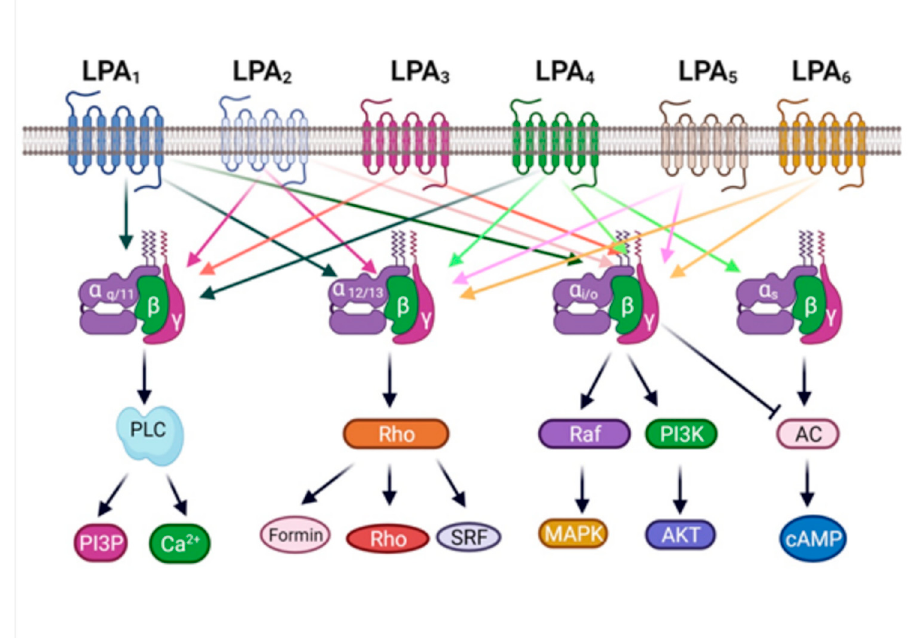
Figure 2. LPA receptors and G proteins. LPA receptors couple with different G proteins that activate distinct signaling pathways. PLC, phospholipase C; PI3K. phosphoinositide 3-kinase; AC, adenylyl cyclase. Created with BioRender.com.